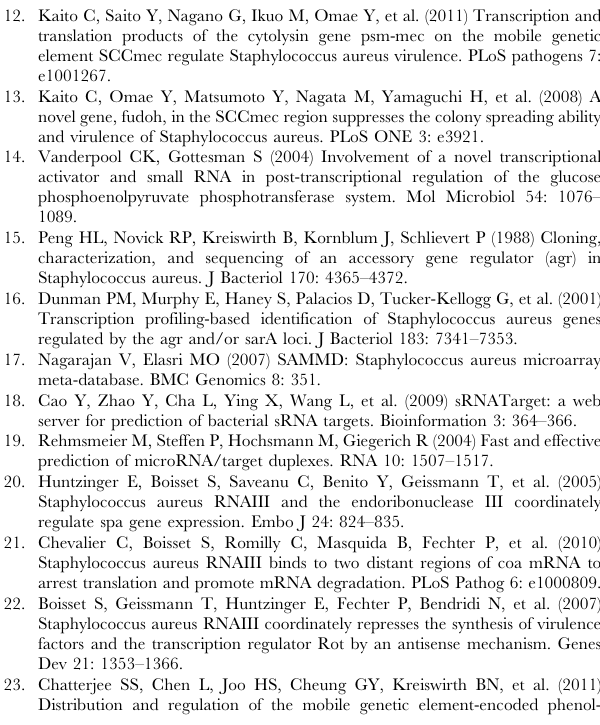
Figure S4 Deletion of psm-mec from clinical MRSA isolates. ( A ) Schematic representation of the genomic region around psm-mec in type-II SCC mec . psm-mec was deleted by tetL in NI-13, NI-18, CR-